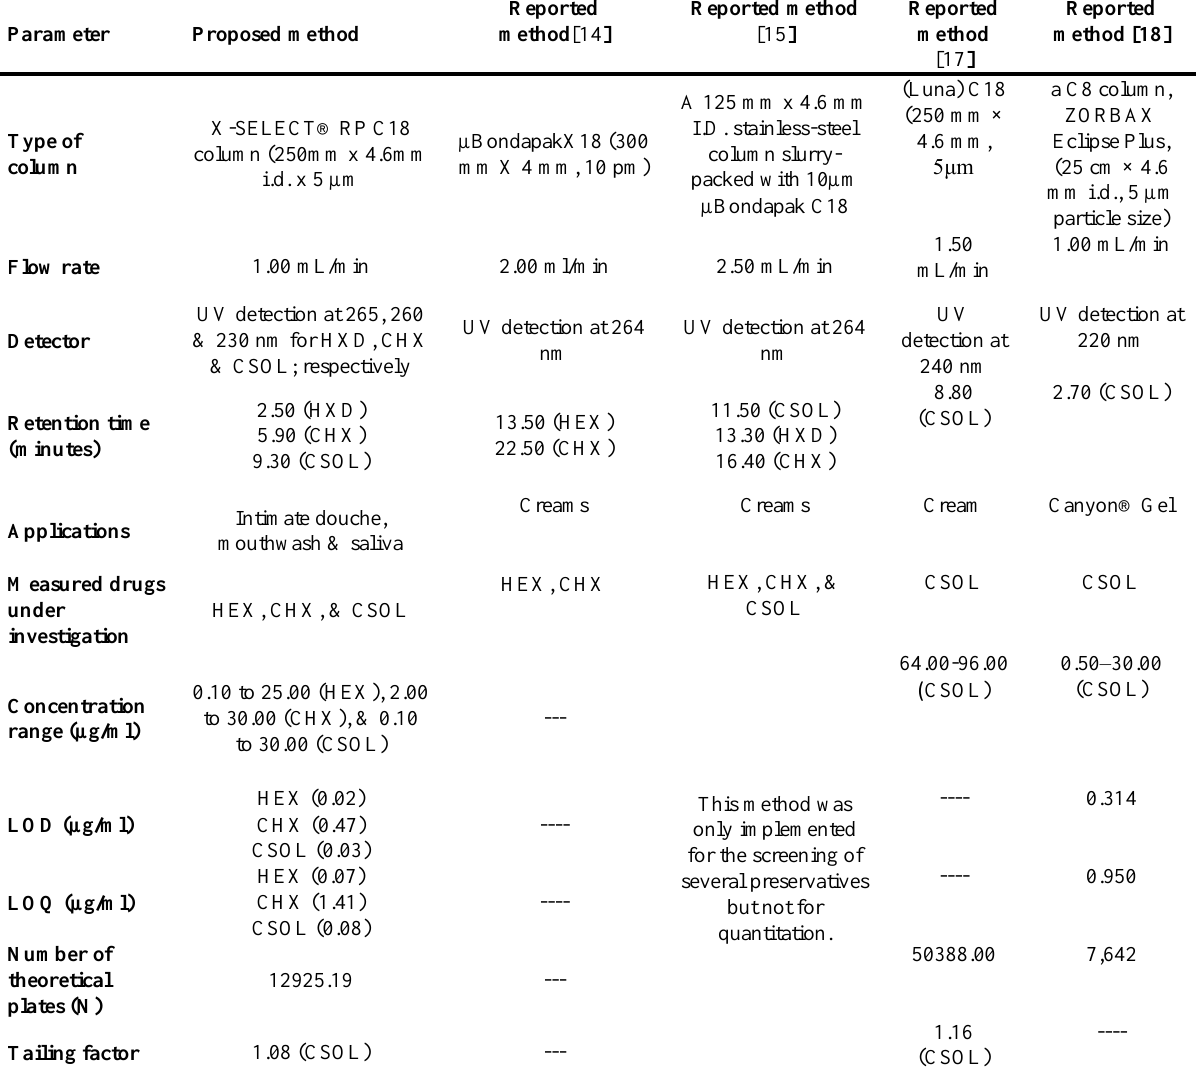
Table 1. Comparison of the results obtained using the proposed HPLC method versus the reported methods [14,15,17,18] for HEX, CHX, and CSOL